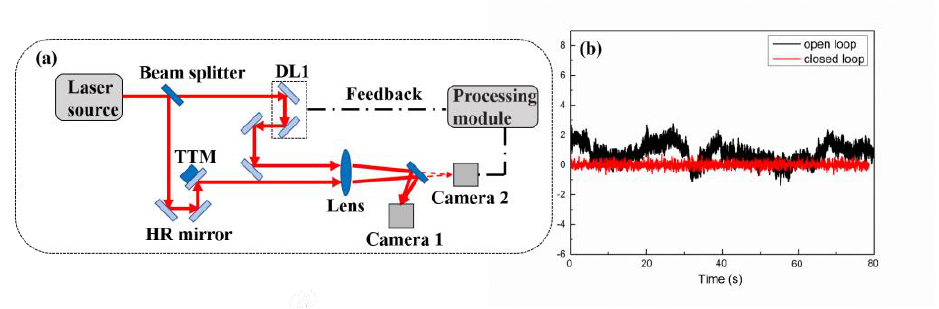
Fig. 2. (a) Experiment setup. DL1 is delay line, HR mirror is high reflected mirror, and TTM is tip-tilt mirror. (b) Phase errors recorded in the open loop and closed